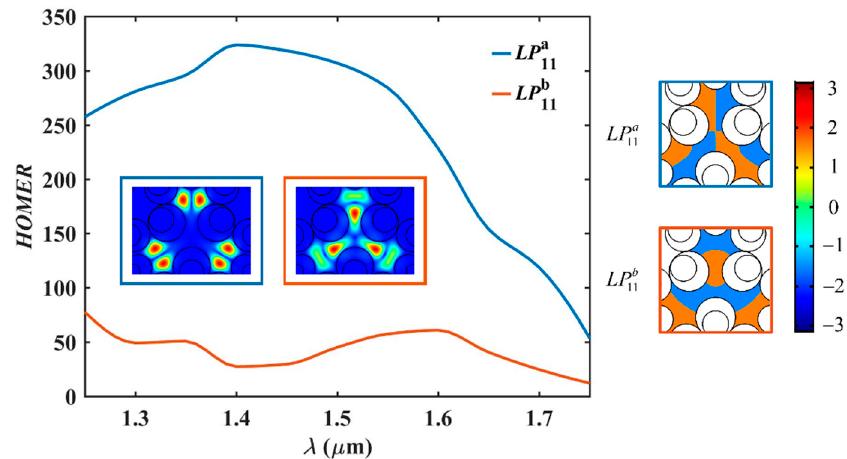
Figure 14. The change in HOMER with λ . The two most representative electric field distributions of the high-order supermodes LP a 11 11 and LP b are on the left, and their corresponding phase distributions are on the right. The color legend is for the phase distributions.